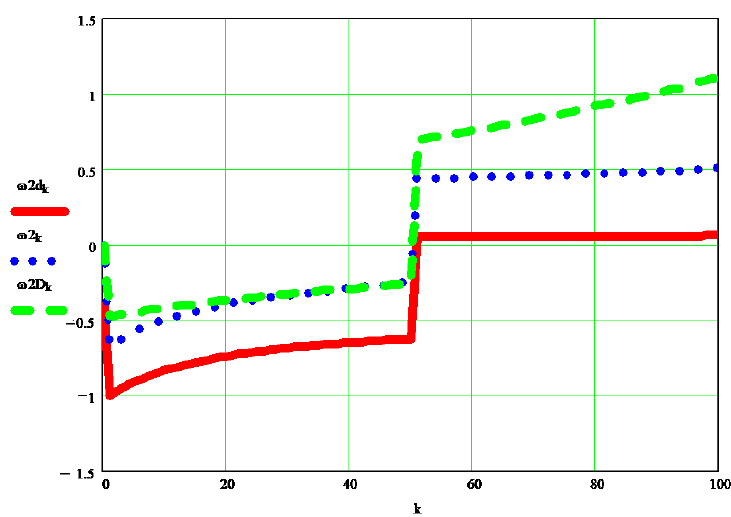
Figure 14. A comparison between the dynamic speed w 2 d [s − 1 ] obtained by the original method presented, and the dynamic speed w 2 D [s − 1 ] obtained through the classically improved method.